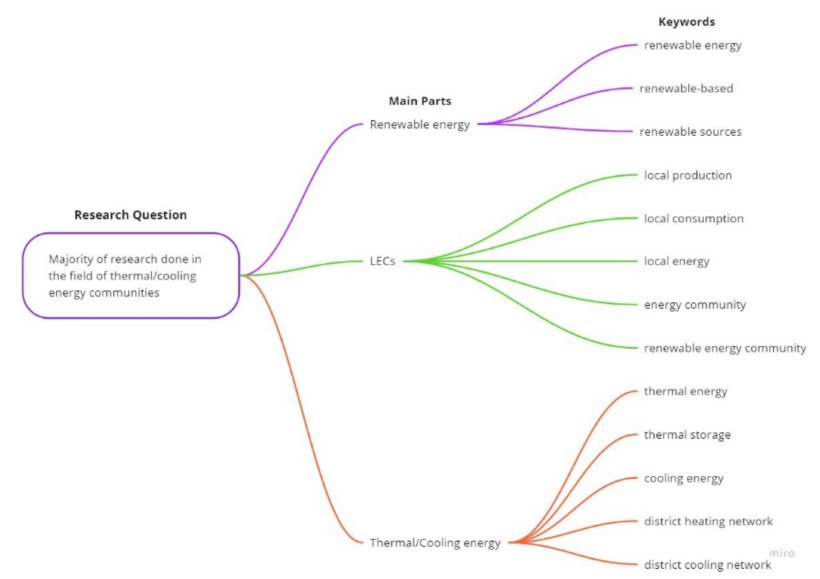
Figure 2. Graphical representation of the keywords targeting the 2nd research question.